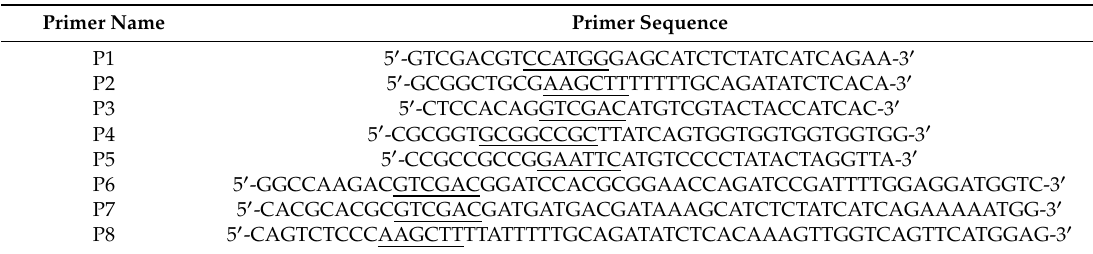
Table 2. Primers for